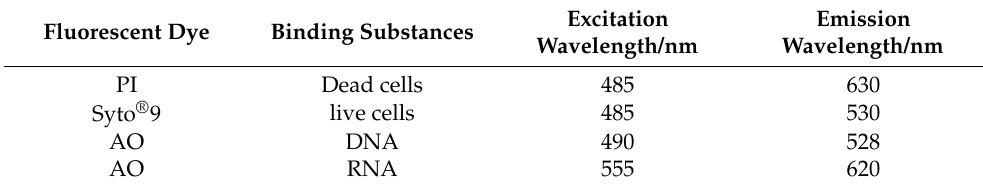
Excitation Emission Wavelength/nm Wavelength/nm